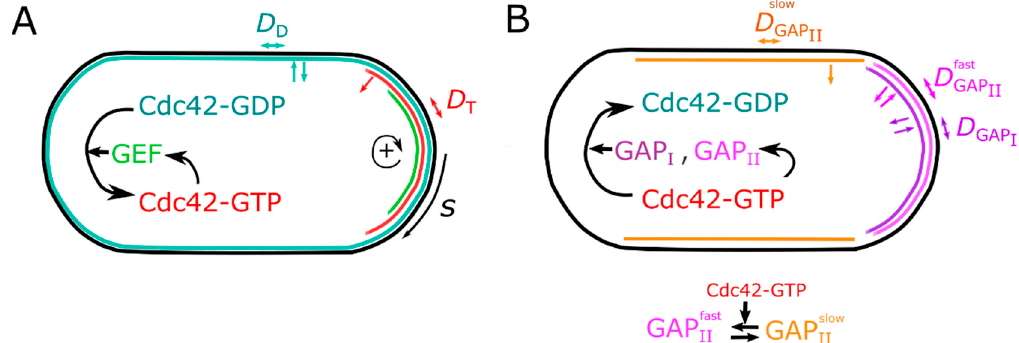
Figure 1. Modeling Cdc42 activation and regulator distribution. ( A ) Schematic illustrates GEF-mediated